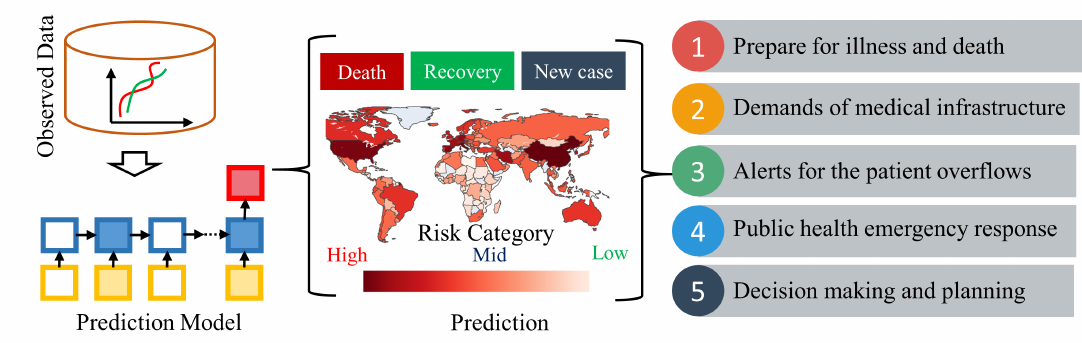
Figure 1. Artificial intelligence (AI) method for trend prediction and applications of such